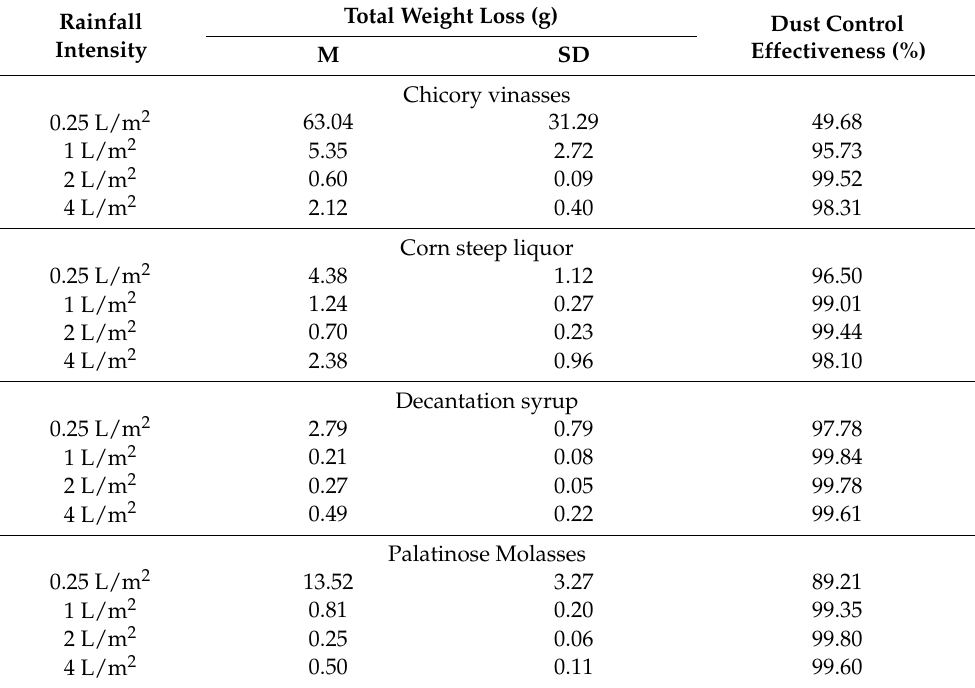
Table A2. Total weight loss (g) of mine soils treated with different food processing by-products and rainfall intensities (arithmetic mean with standard deviation, n = 3). The quantitative dust control effectiveness represents the ratio of total weight loss between treated and untreated mine soil. Untreated mine soil showed a total weight loss of 125.28 g after four measuring cycles.